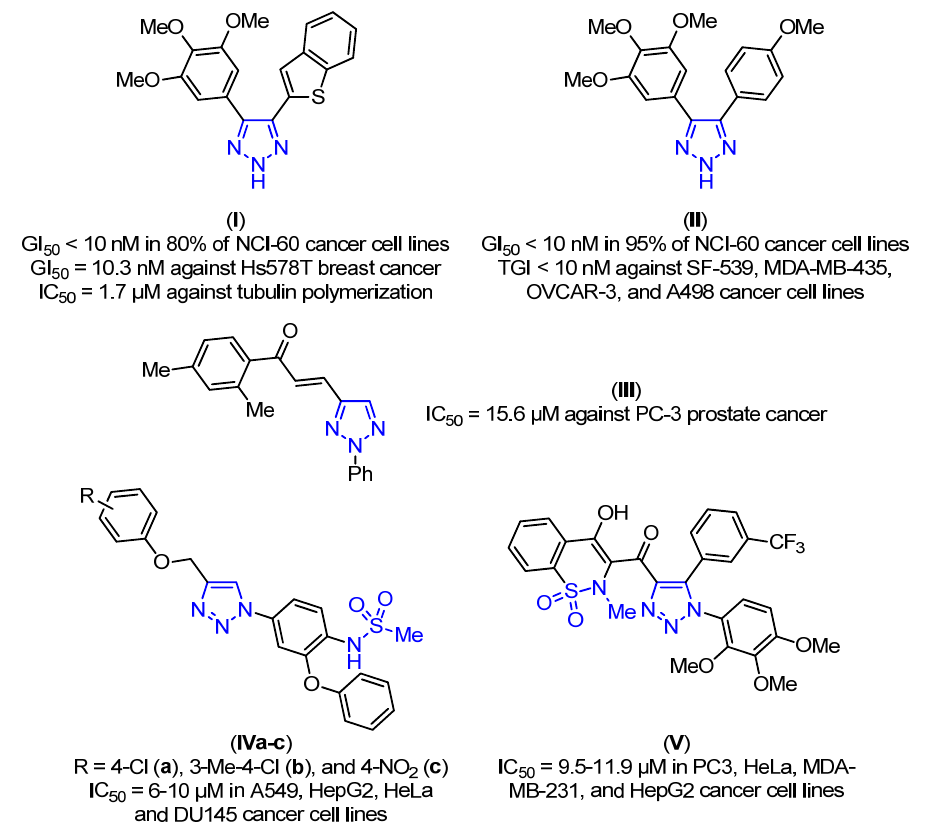
Figure 2. 2 H ‐ 1,2,3 ‐ Triazole ‐ containing hybrids with anticancer activity. Figure 2. 2 H -1,2,3-Triazole-containing hybrids with anticancer